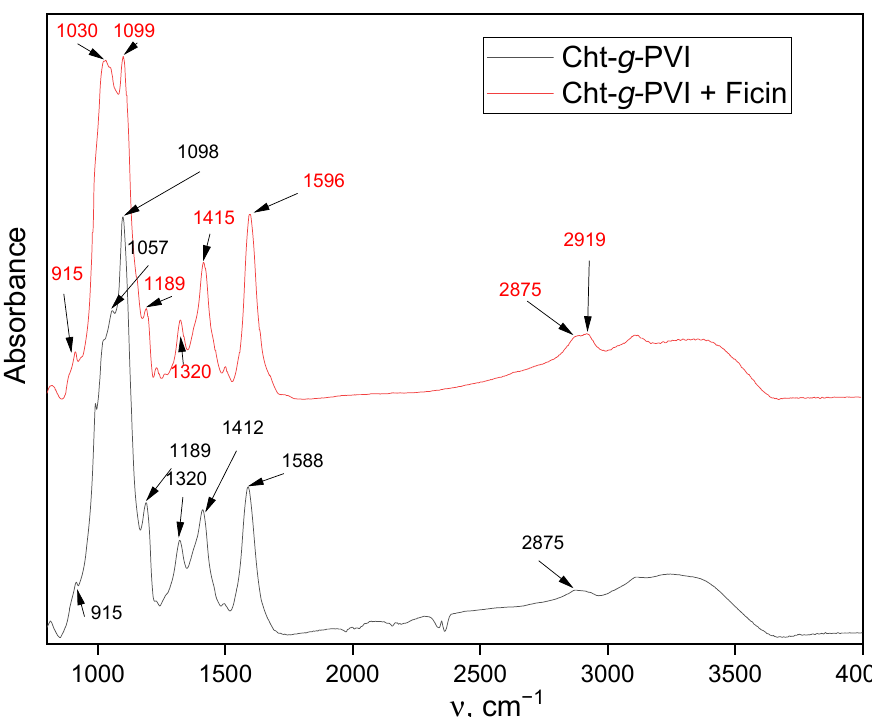
Figure 1. The FTIR spectra of Cht- g -PVI copolymer and it conjugate with ficin.